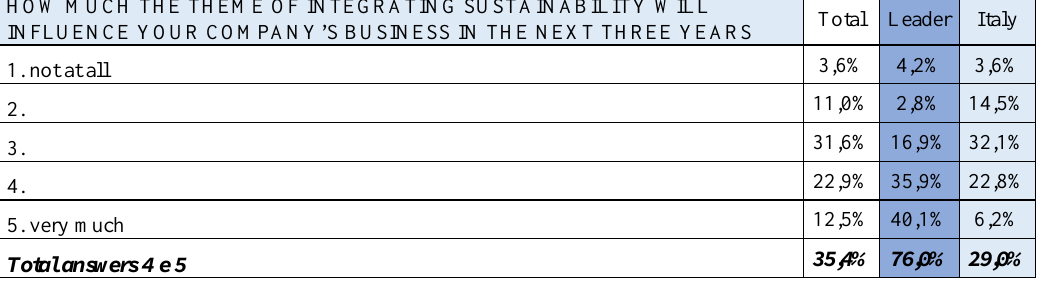
HOW MUCH THE THEME OF INTEGRATING SUSTAINABILITY